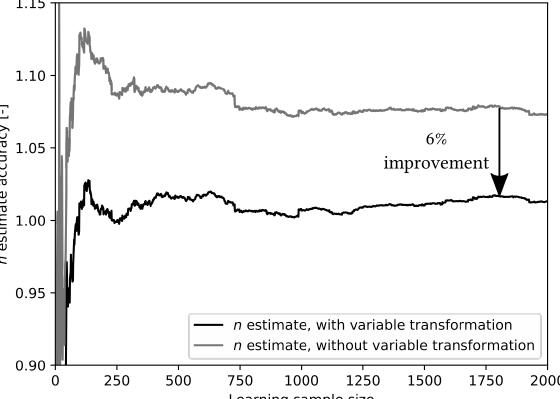
Figure 5. Evolution of the accuracy of the estimate of Taylor’s parameter n with learning sample